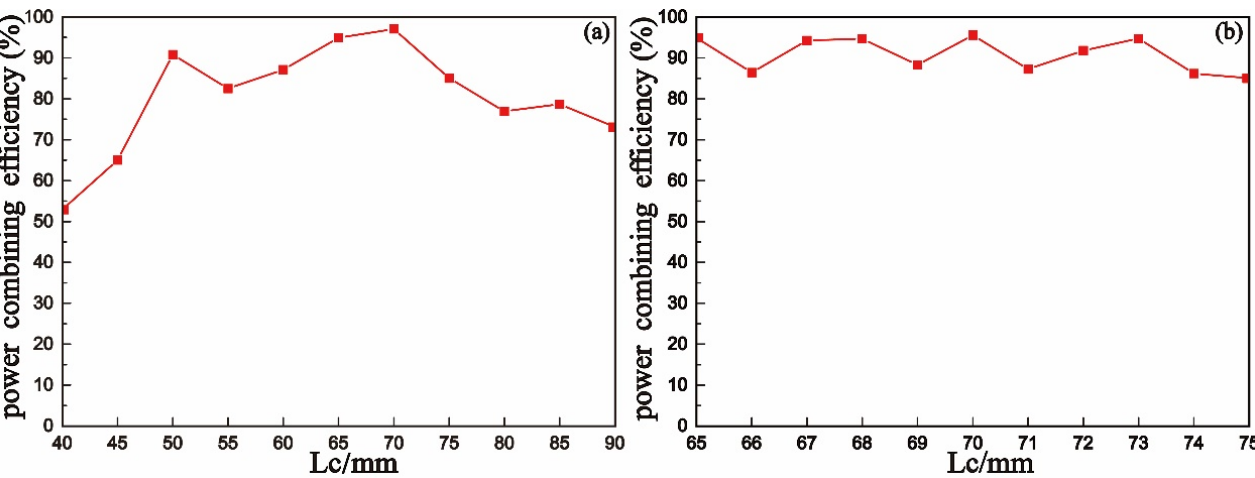
Figure 6. Power-combining efficiency under different coupling slot lengths L c : ( a ) the L c with large interval, ( b ) the L c with small interval.